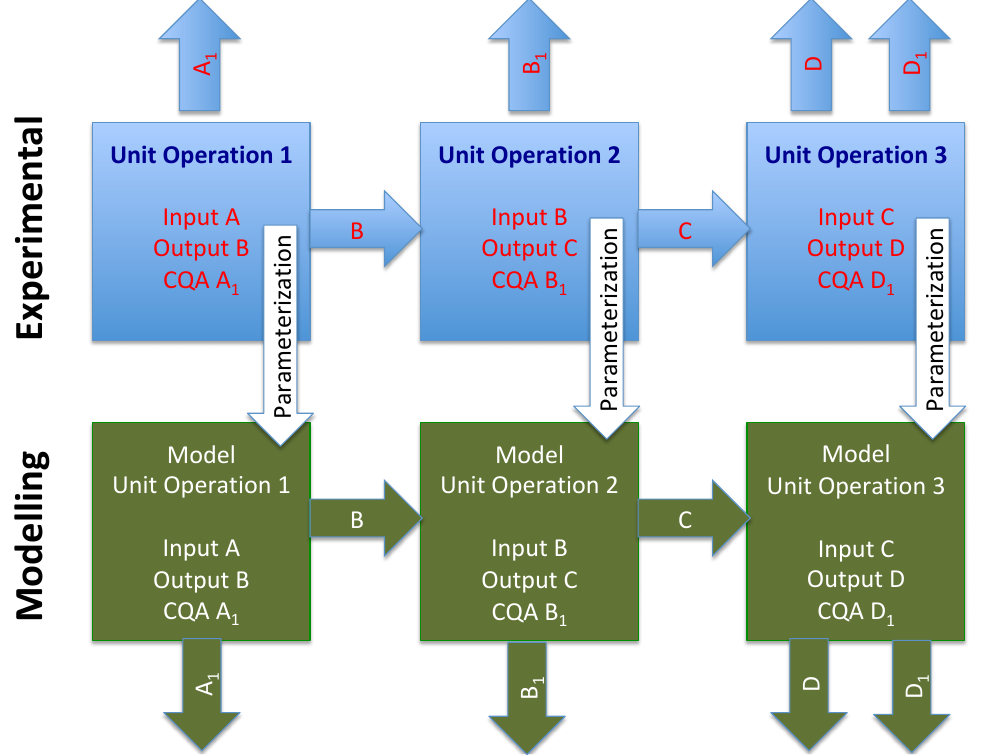
Figure 1. Top row in blue color: Experimental set-up of three unit operations. The output values of the individual unit operations B and C are used as input values for the next unit operations. In addition, there exist certain CQA values such as A 1 , B 1 , D 1 , and the final process outcome D. The corresponding experimental data is used for the parameterization or the training of models for the individual unit operations (bottom row in green color). Three models represent the process behavior at the unit operation stage and can be used for predictions. The results of the model predictions are used as input values for the next models in combination with further CQAs. The corresponding transfer functions with the model outputs are represented as green horizontal